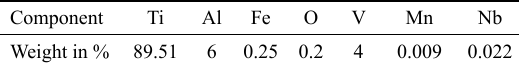
Table 1. Chemical compositions of Ti-6Al-4V.